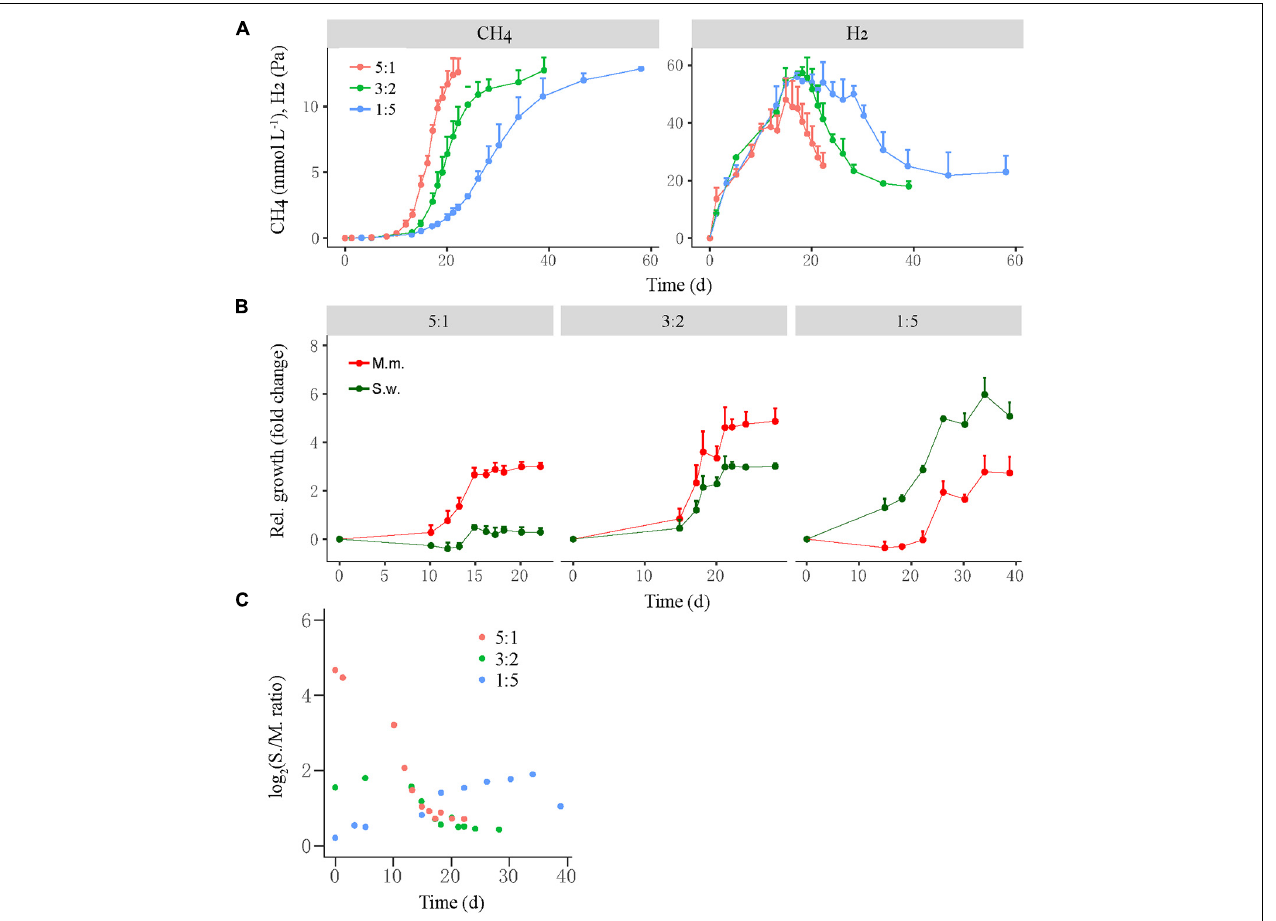
FIGURE 3 | The production of CH 4 and H 2 from butyrate oxidation (A) by a mesophilic coculture consisting of Syntrophomonas wolfei (S.w.) and Methanococcus maripaludis (M.m.) and their growth synchronization (B,C) . Three levels of syntroph-to-methanogen cell ratios (i.e., 5:1, 3:2, and 1:5) were created at the beginning by inoculating different population sizes to fresh medium, which were designated as the high, middle, and low cell ratio treatments, respectively. The relative growth (B) of the individual populations was estimated as the fold change of cell number at any timepoint relative to that at the beginning. Note that the change in Syntrophomonas – Methanococcus cell ratio over time (C) is shown in normal scale. The error bars in (A,B) indicate the positive values of standard deviation of four